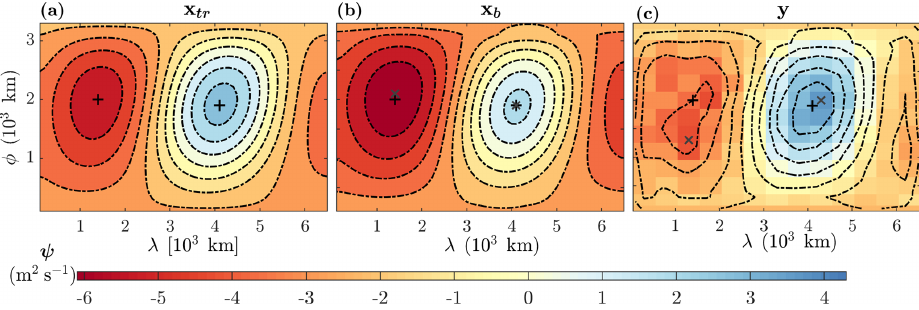
Figure 6. (a) The true state x tr , (b) background state x b , and (c) observations y for the bottom layer field of the streamfunction in the quasi-geostrophic model at the first assimilation cycle T = 12h. The black plus (grey cross) signs show the location of the global extrema for the true state (background and observation).